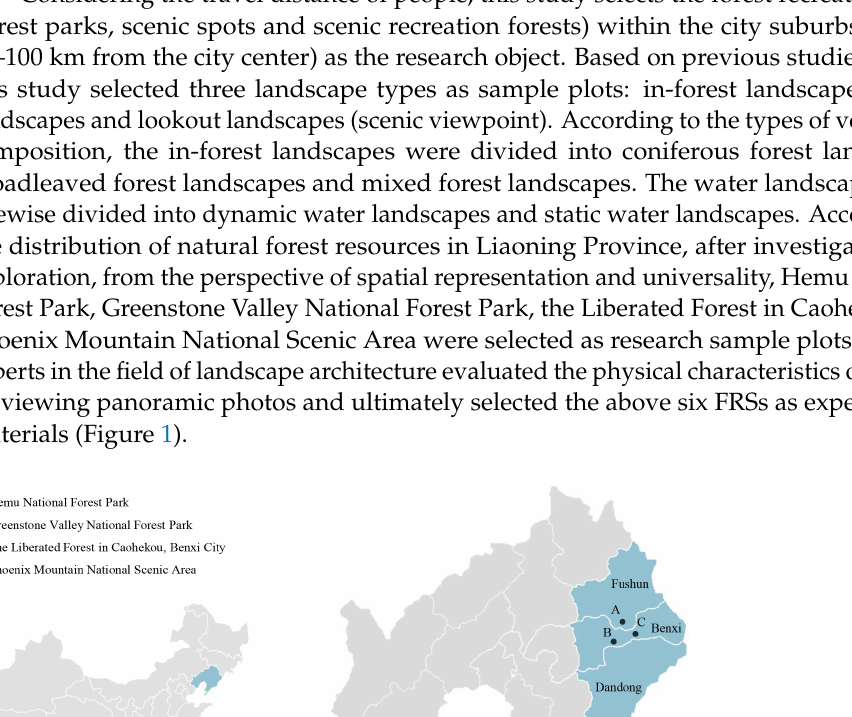
Table 1. Videos of six different types of forest landscapes.